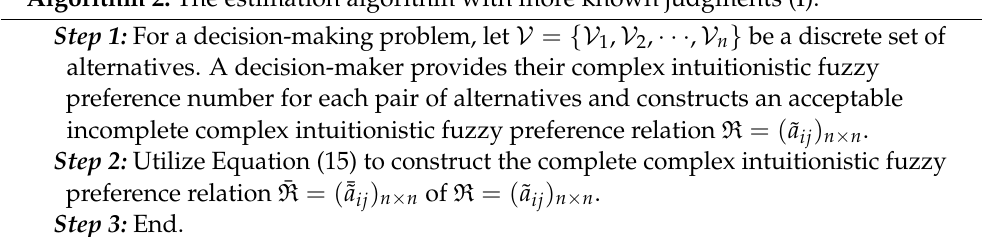
Algorithm 2: The estimation algorithm with more known judgments